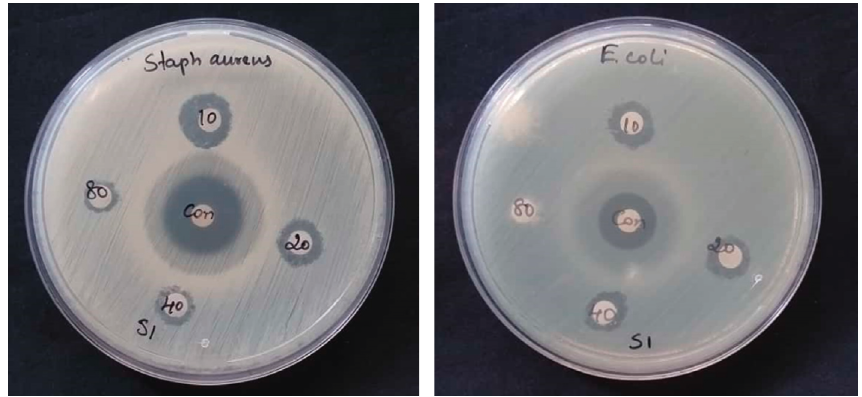
Figure 12: Antibacterial activity of silver nanoparticles.